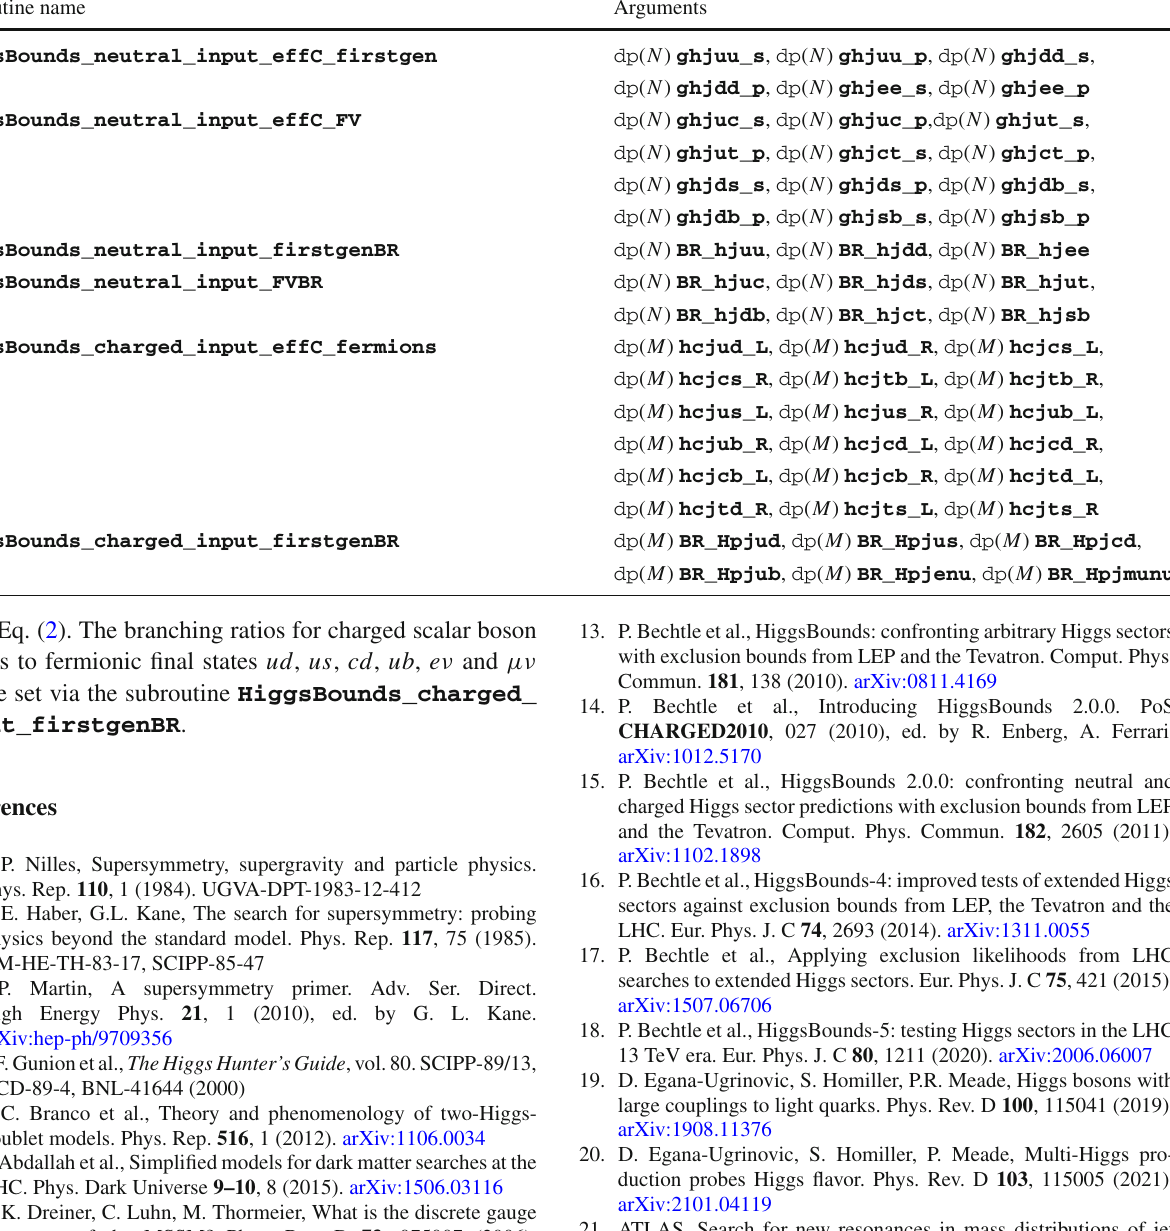
array length quoted in parentheses. The number of neutral and charged scalar bosons in the model are denoted by N and M ,